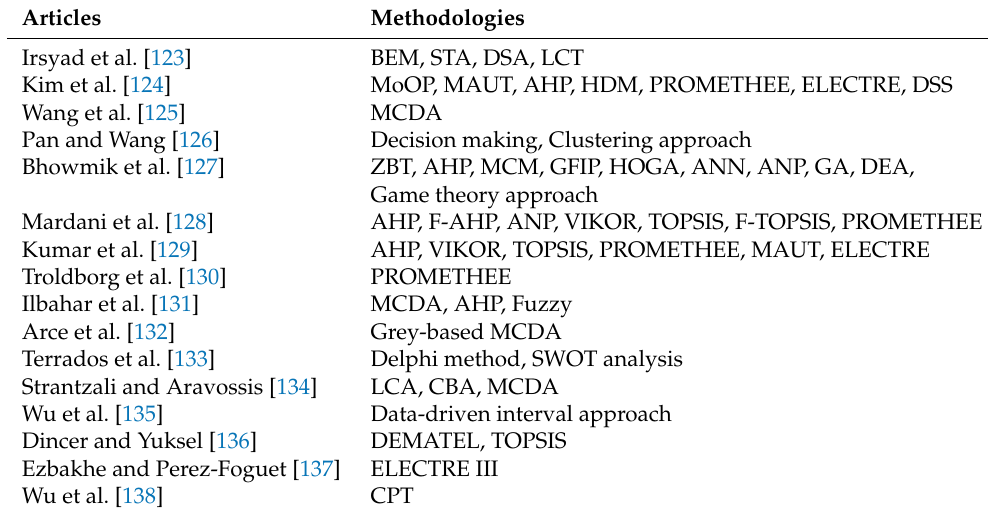
Table 2. Articles used following methodologies frequently for analyzing RE and its